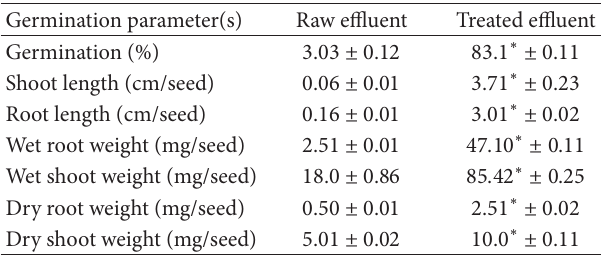
Table 2: Various seed germination parameters of raw and